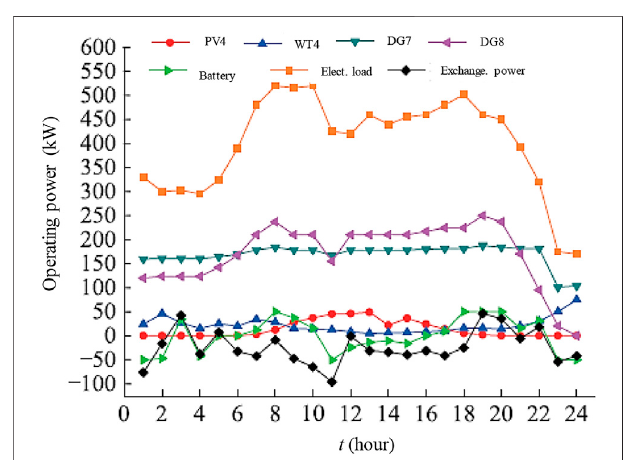
FIGURE 10 | Comparison of power optimization of the second region.